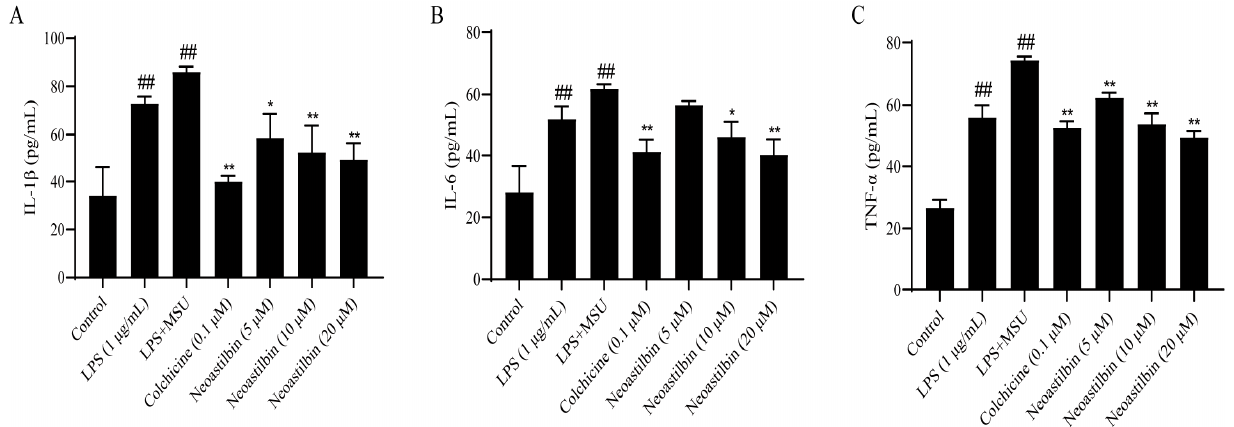
Figure 2. Effect of neoastilbin on the secretion of inflammatory cytokines in THP-1-derived macrophages. Macrophages were incubated for 24 h with LPS (1 μ g/mL), followed by incubation for 0.5 h with neoastilbin, then incubating with MSU (500 μ M) for an additional 23.5 h. Supernatants were analyzed by ELISA for IL-1 β ( A ), IL-6 ( B ) and TNF- α ( C ) levels. Data in the figures represent the means ± SD; significant differences among different groups are indicated as ## p < 0.01 vs. control group, * p < 0.05, ** p < 0.01 vs. LPS+MSU group ( n = 3).